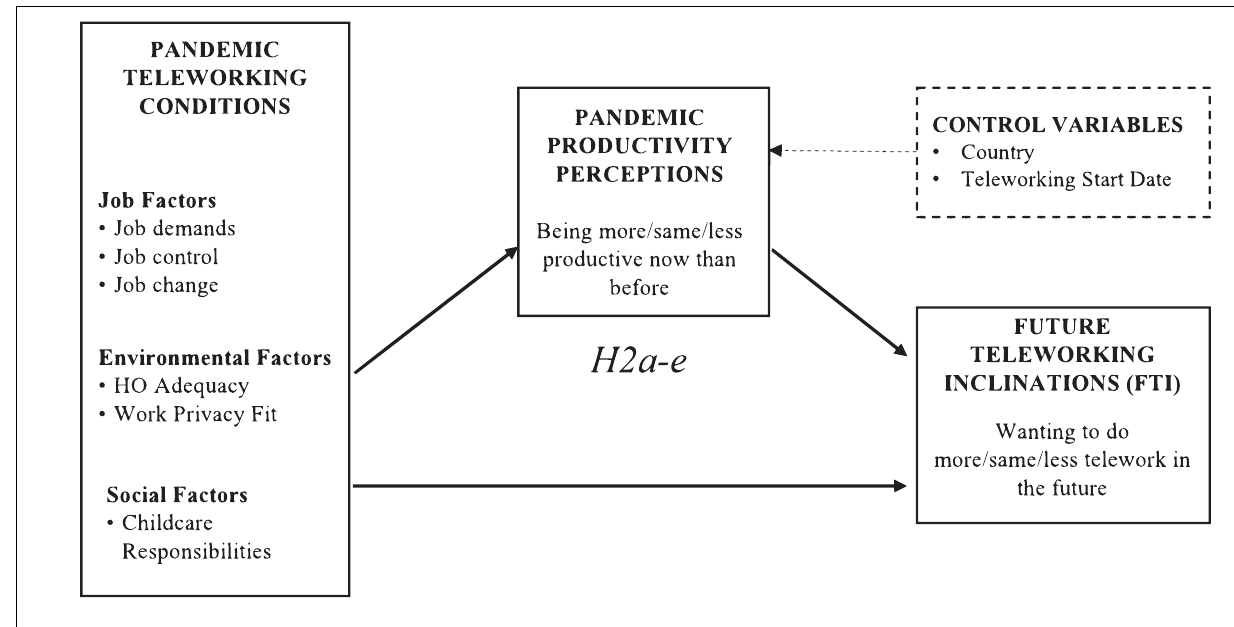
FIGURE 3 | Hypothesised relationships